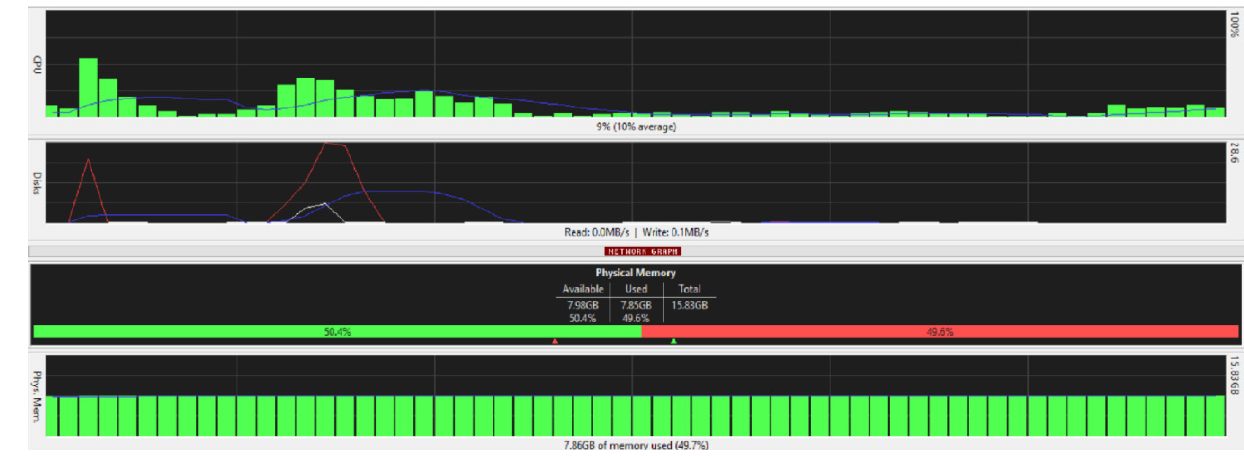
Figure 26. Running the monitoring tool after the application is in process (block creator).